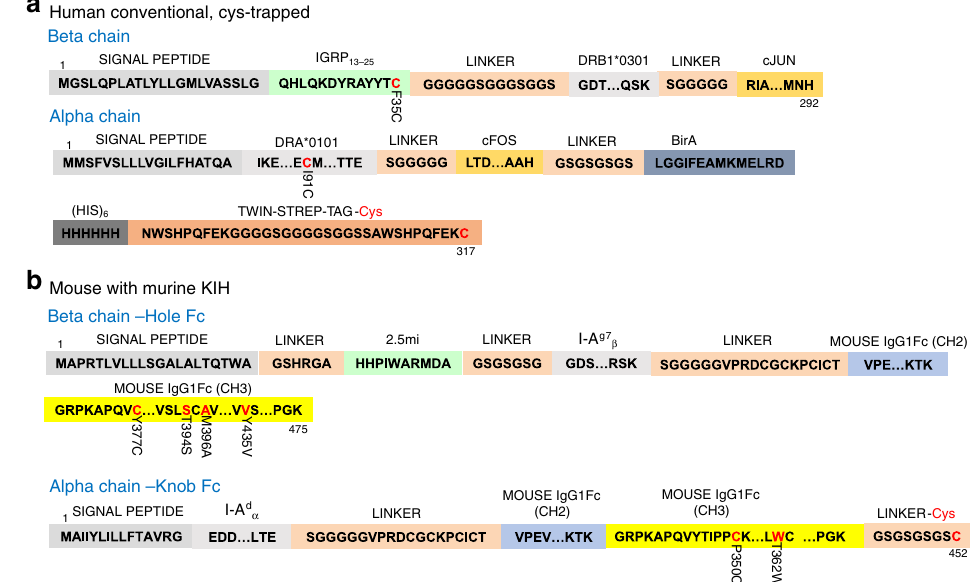
Fig. 2 Key junctional, linker and motif sequences for cys-trapped human pMHCII and mKIH-based mouse pMHCII. a Key amino acid sequences of human pMHCII molecules encoding a cys-trapped IGRP 13 – 25 /DRA1*0101/DRB1*0301 pMHCII heterodimerized via c-jun/c-fos leucine zippers (also referred to “ conventional ” ). ‘…’ is used to indicate that corresponding intervening amino acid sequences are not shown, as they are publicly available. Residues in red are mutated and the original residue and its position are indicated immediately below. b Key amino acid sequences of a mouse pMHCII molecule encoding BDC2.5mi/IA α d /IA β g7 heterodimerized using a carboxyterminal mouse IgG1-Fc-based